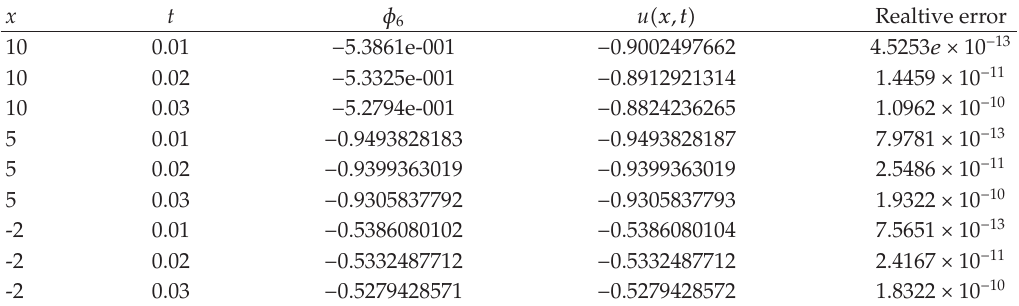
Table 1: The comparison of the results of the HAM (cid:3) h (cid:8) − 1 (cid:4) and exact solution for the u (cid:3) x,t (cid:4) , α (cid:8) β (cid:8)